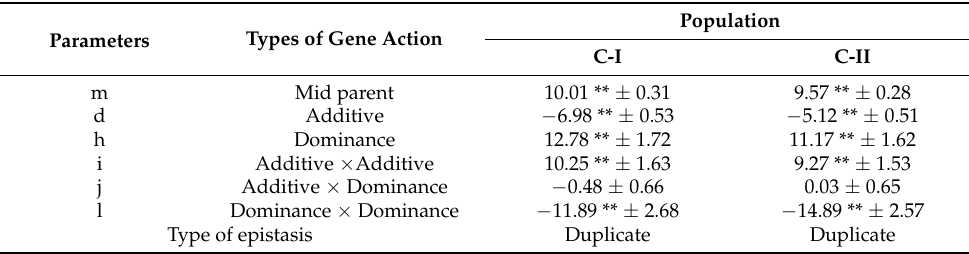
Table 6. Estimates of the additive, dominance, and interaction parameters for mean lesion length (cm) in C-I and C-II populations of Indian